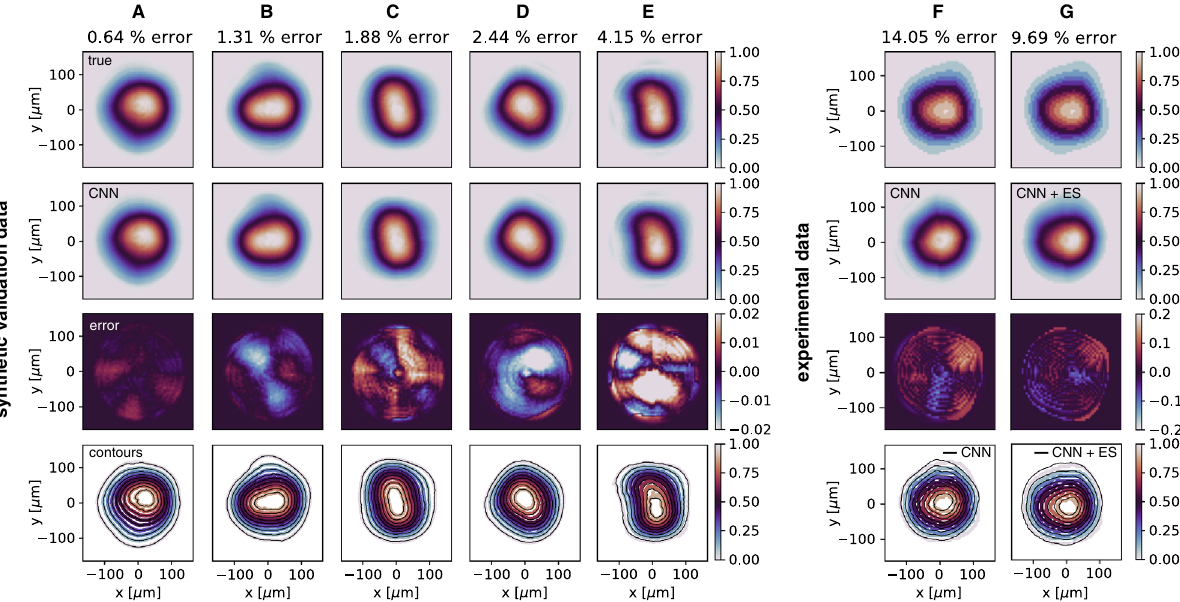
Figure 6. ( A – E ) Comparing input distributions to the CNN predictions reconstructed from the predicted PCA component coefficients. 5 examples were chosen from the 1000 test distributions and show the CNN’s best prediction ( A ), worst prediction ( E ), and a uniformly spaced range between ( B – D ). ( F ) The CNN’s prediction is shown for an experimentally measured beam output and compared to the experimentally measured beam input. ( G ) Results of the prediction from ( F ) fine tuned via